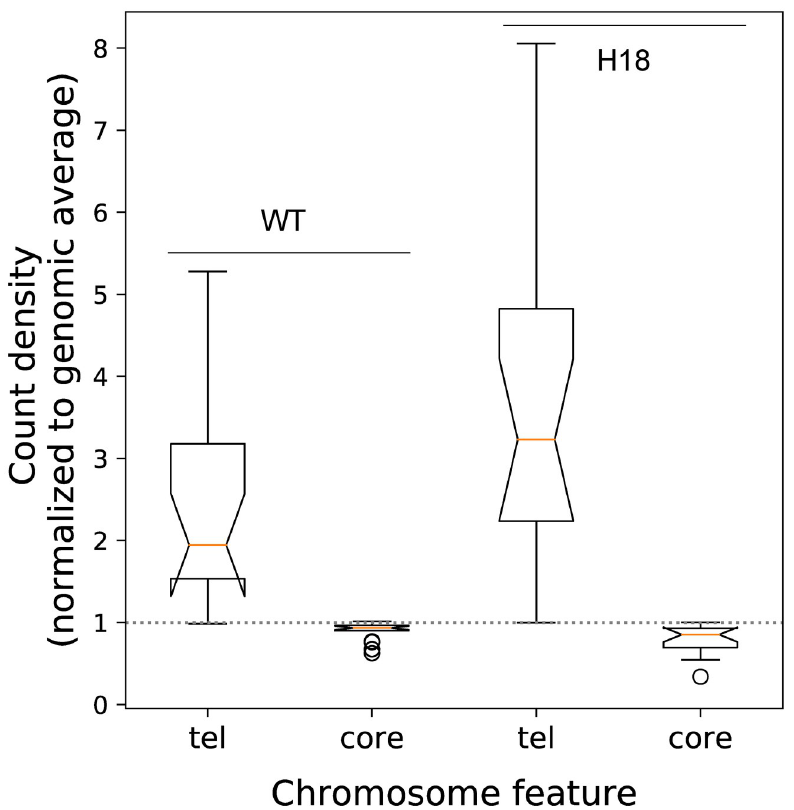
Fig 5. Rap1 binding in the genome. The level of Rap1 bound to the 20kb chromosome termini (tel) and the internal core regions excluding the termini (core) were determined from the ChIP-seq signal for each of the 16 chromosomes, and normalised to the genome average. The values are shown for the WT and H4H18A mutant strains. The box plots represent the inter-quartile range (IQR), the notch represents the significance at p < 0.05, the orange line shows the median, and the whiskers is shown at 1.5 × the IQR. Outliers are shown as individual data points.